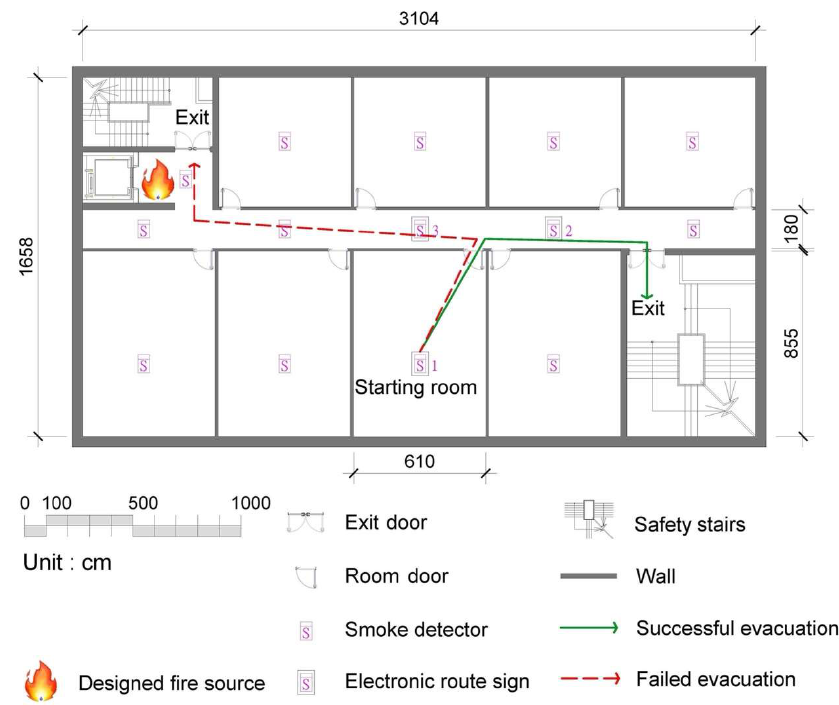
Figure 4. Floor plan of the experimental environment.